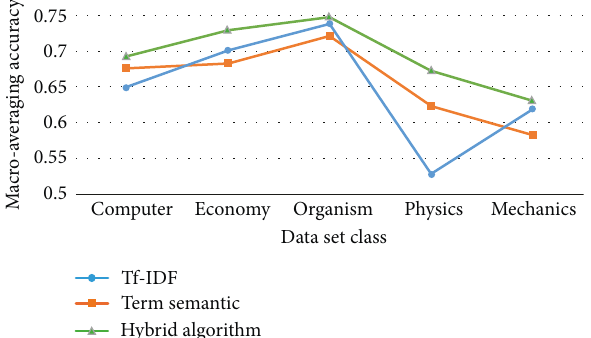
Figure 11: Macroaverage accuracy analysis of three methods in DKM algorithm.